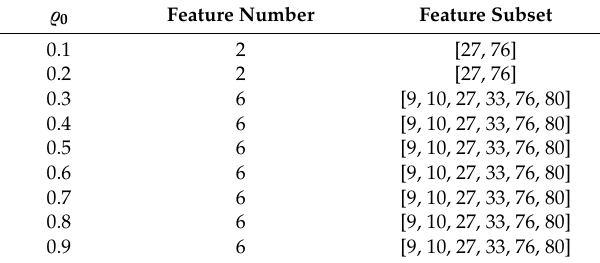
Table 5. Features acquired on the UDP flow dataset when (cid:37) 0 values are di ff